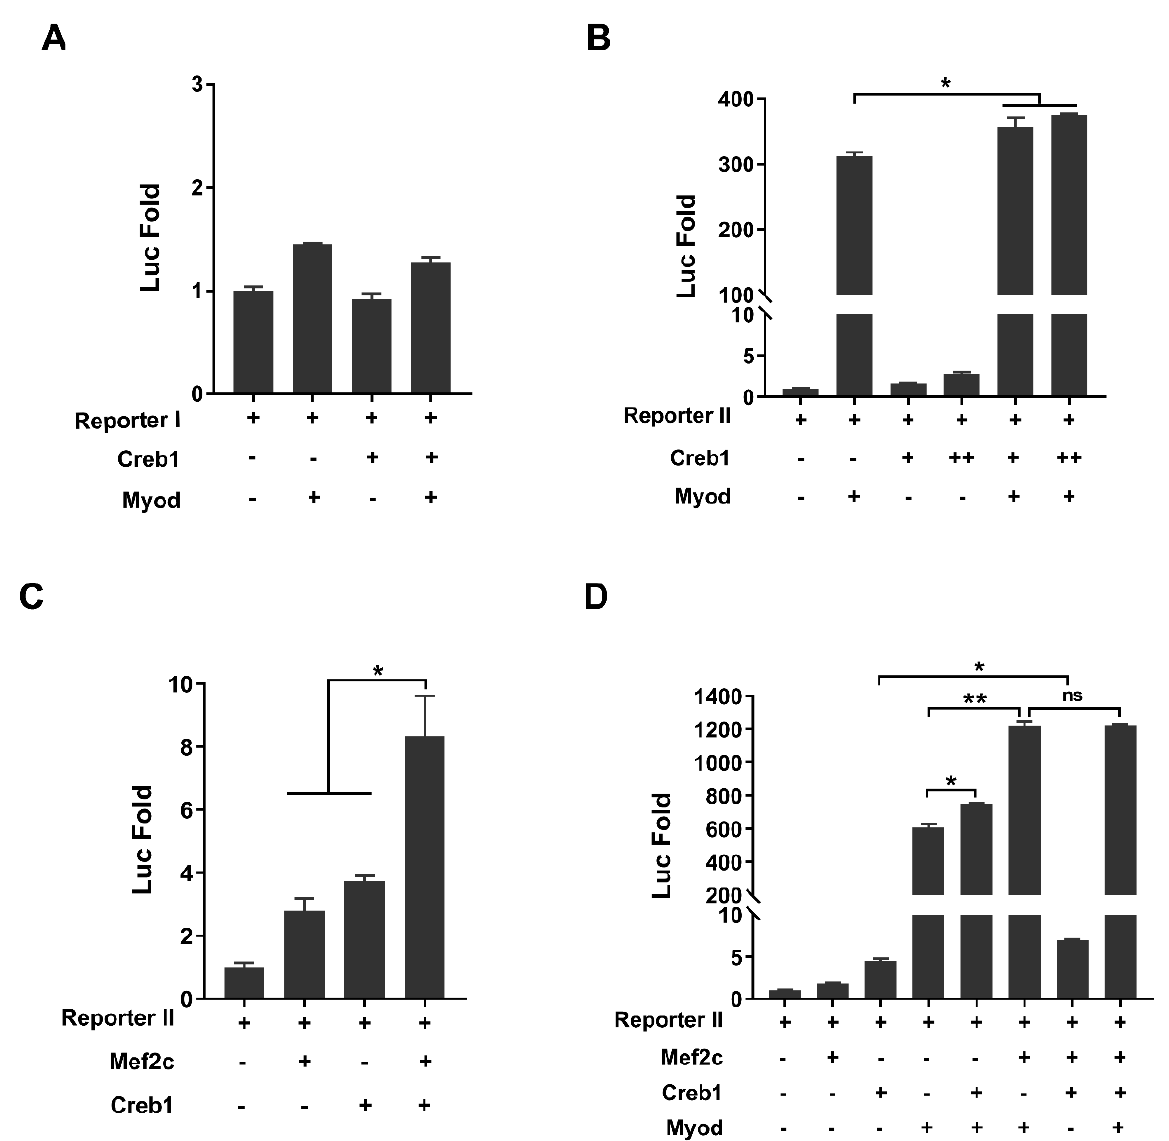
Figure 4. Transactivation of Reporter II by Myod, Mef2c and Creb1. ( A ) Reporter I is not responsive to Myod, Creb1 or the Myod/Creb1 complex in HEK293T cells. ( B ) Reporter II is synergistically transactivated by Myod and Creb1 up to 376-fold, while the transactivation is around 311-fold by Myod, and around 3-fold by Creb1 in HEK293T cells. ( C ) Reporter II is synergistically transactivated up to 8.3-fold, as the transactivation is 2.8-fold by Mef2c and 3.7-fold by Creb1 in HEK293T cells. ( D ) Transactivation of Reporter II by Myod, Creb1 and Mef2c. Reporter II can be transactivated synergistically by Mef2c/Creb1, Mef2c/Myod or Creb1/Myod in HEK293T cells. The transactivation of Reporter II has been saturated with all three factors: Mef2c, Creb1 and Myod. All data are shown as mean ± S.D from three replicates. * p < 0.05; ** p < 0.01 and ns, not